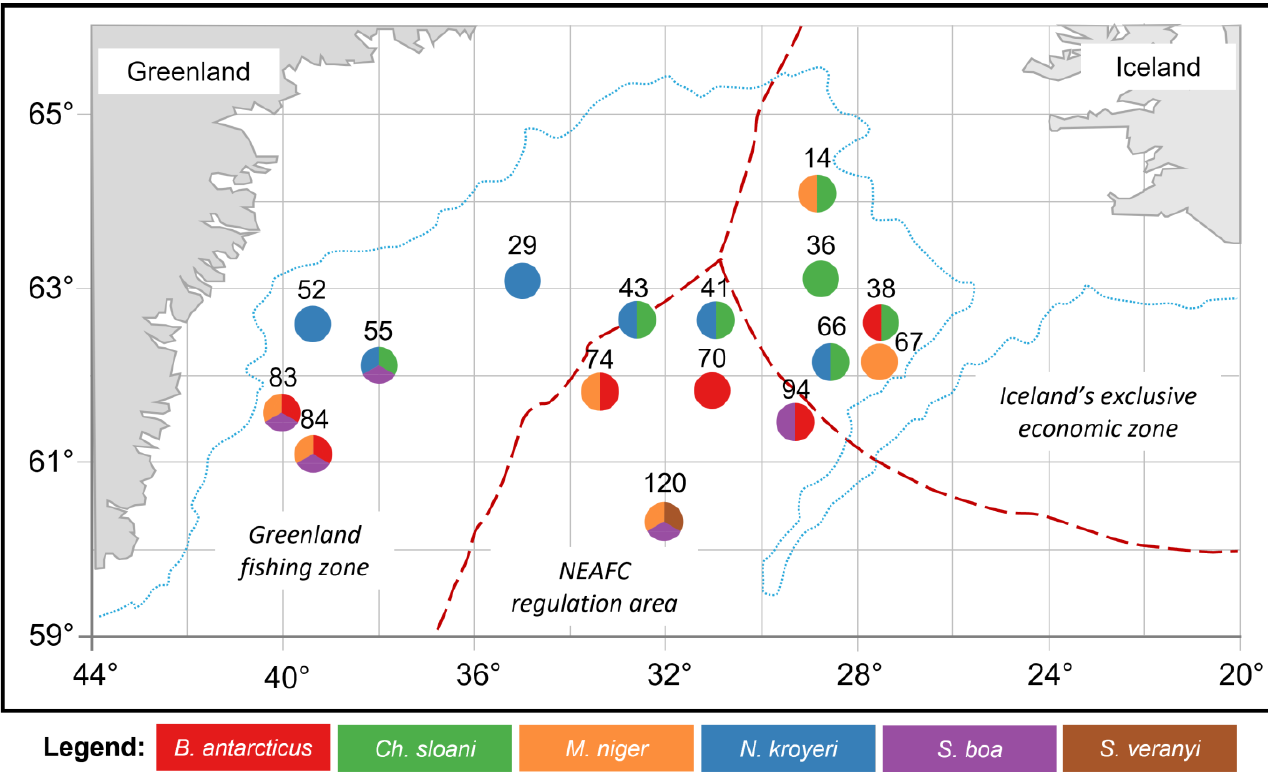
Figure 1. Schematic map of the collection sites of the mesopelagic fishes ( Notoscopelus kroyeri , Symbolophorus veranyi , Chauliodus sloani , Stomias boa , Malacosteus niger , and Borostomias antarcticus ) in the Irminger Sea (North Atlantic).